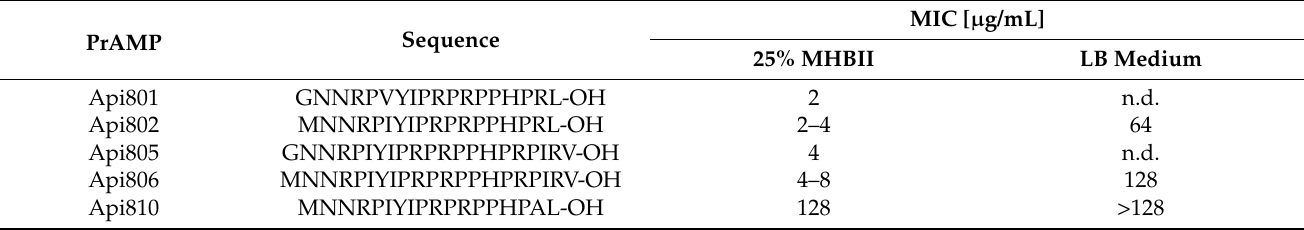
Table 1. Sequences and MICs of antimicrobial peptides included in this study against E. coli